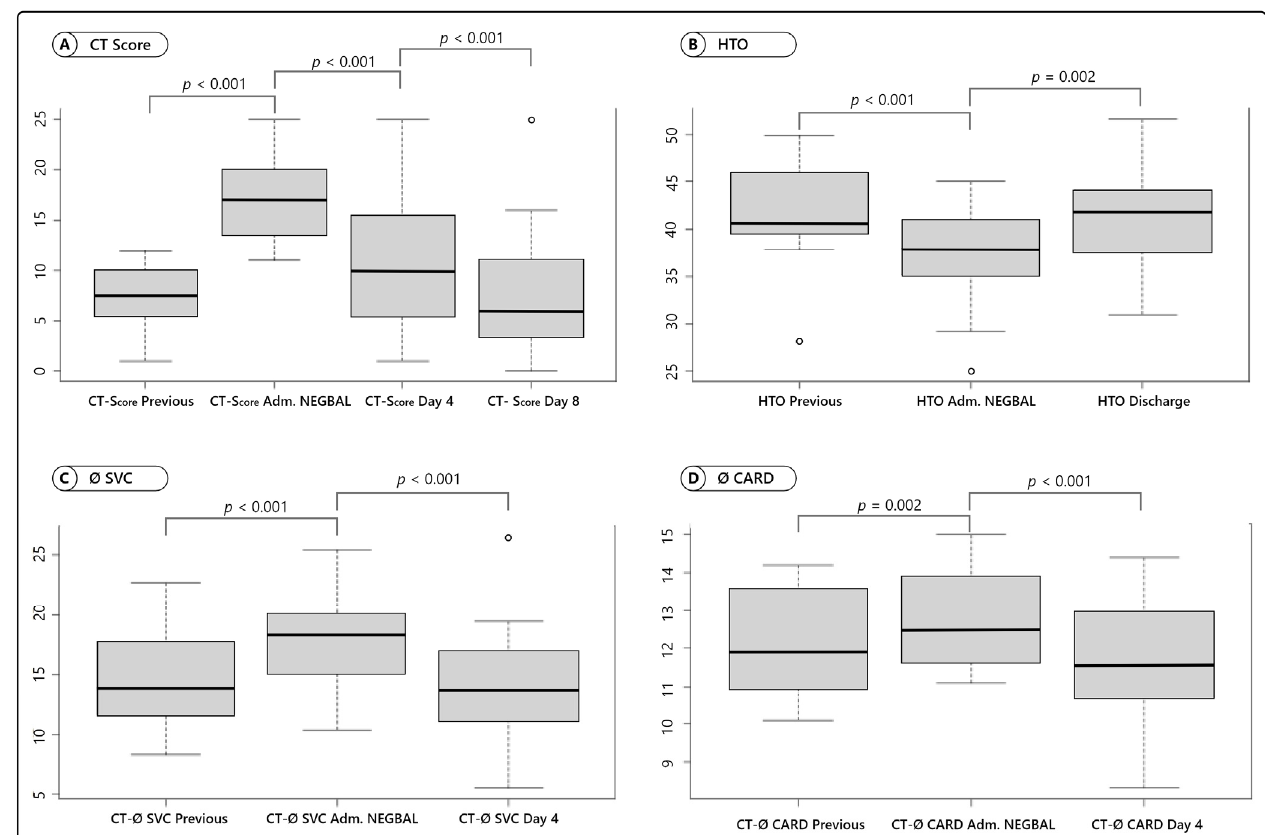
Figure 2. CT score evolution pre- and post-NEGBAL of CT, HTO, Ø SVC, and Ø CARD. ( A ) Box plot for CT score previous to NEGBAL, CT score adm. NEGBAL, CT day 4, and CT day 8. ( B ) Box plot for previous HTO, HTO adm. NEGBAL, and HTO day 4. ( C ) Box plot for Ø SVC previous NEGBAL, Ø SVC adm. NEGBAL, and Ø SVC day 4. ( D ) Box plot for Ø CARD previous NEGBAL, Ø CARD adm. NEGBAL, and Ø CARD day 4. Table 3. Statistical analysis of PaO2FiO2, CT score, diameter SVC, cardiac axis, CTR, and hematocrit.